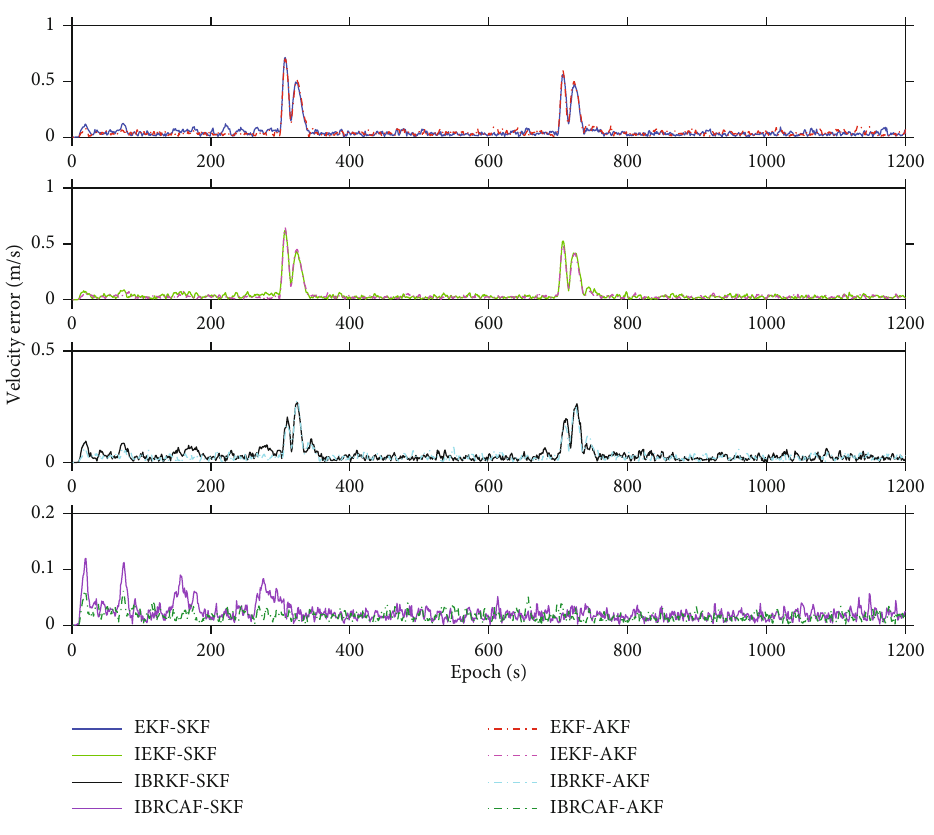
Figure 23: The velocity errors of various algorithms (Data